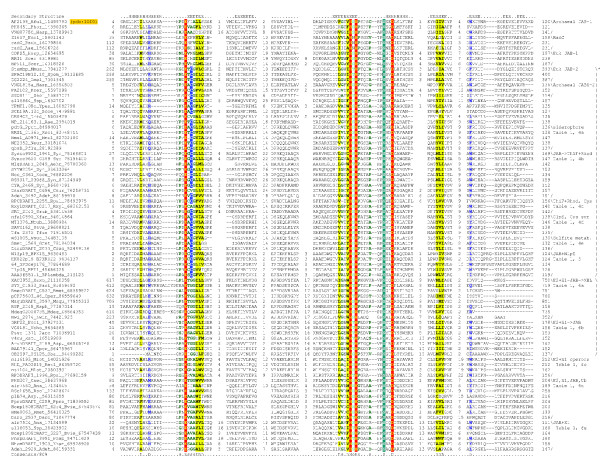
Multiple alignment of JAB domain containing proteins. Coloring is indicative of 80% consensus. The coloring scheme, consensus abbreviations and secondary structure representations are as described in the legend to Figure 2. The secondary structure, shown on the first line of the alignment, is derived from a JAB crystal structure whose primary sequence is found on the second line of the alignment, with PDB identifier shaded in gold. Conserved histidine and acidic residues (ED) are colored yellow and shaded in red. The conserved active site serine residue is colored light gray and shaded in teal. The conserved cysteine found in a subset of JABs (marked with an asterisk) are shaded blue and colored white. The alignment is grouped according to families, with family names listed to the right. Also provided are references to the appropriate row on Table 1, which describes a particular JAB containing operon.